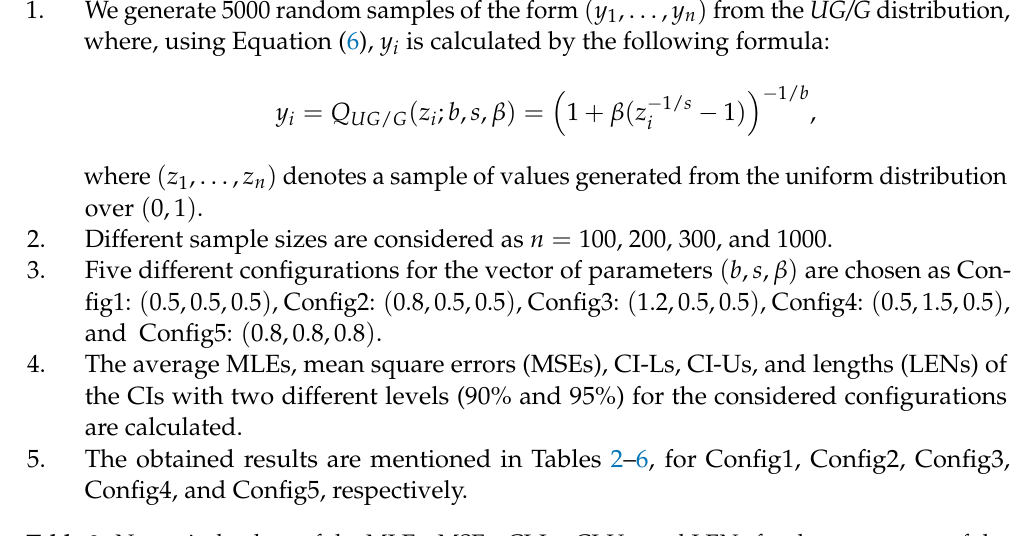
Table 2. Numerical values of the MLEs, MSEs, CI-Ls, CI-Us, and LENs for the parameters of the UG/G model for